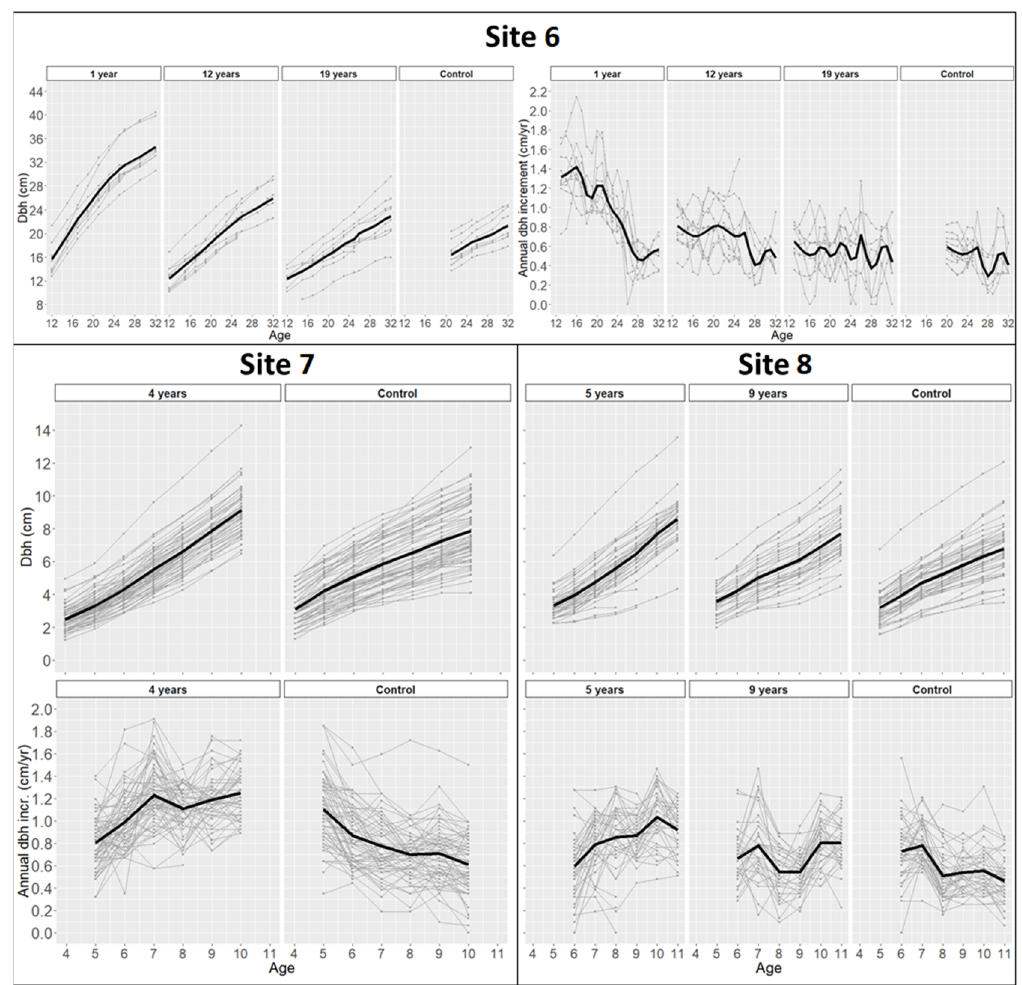
Figure 5. Evolution of dbh (cm) and dbh increment (cm/year) with tree age for each silvicultural treatment of sites 6, 7 and 8.